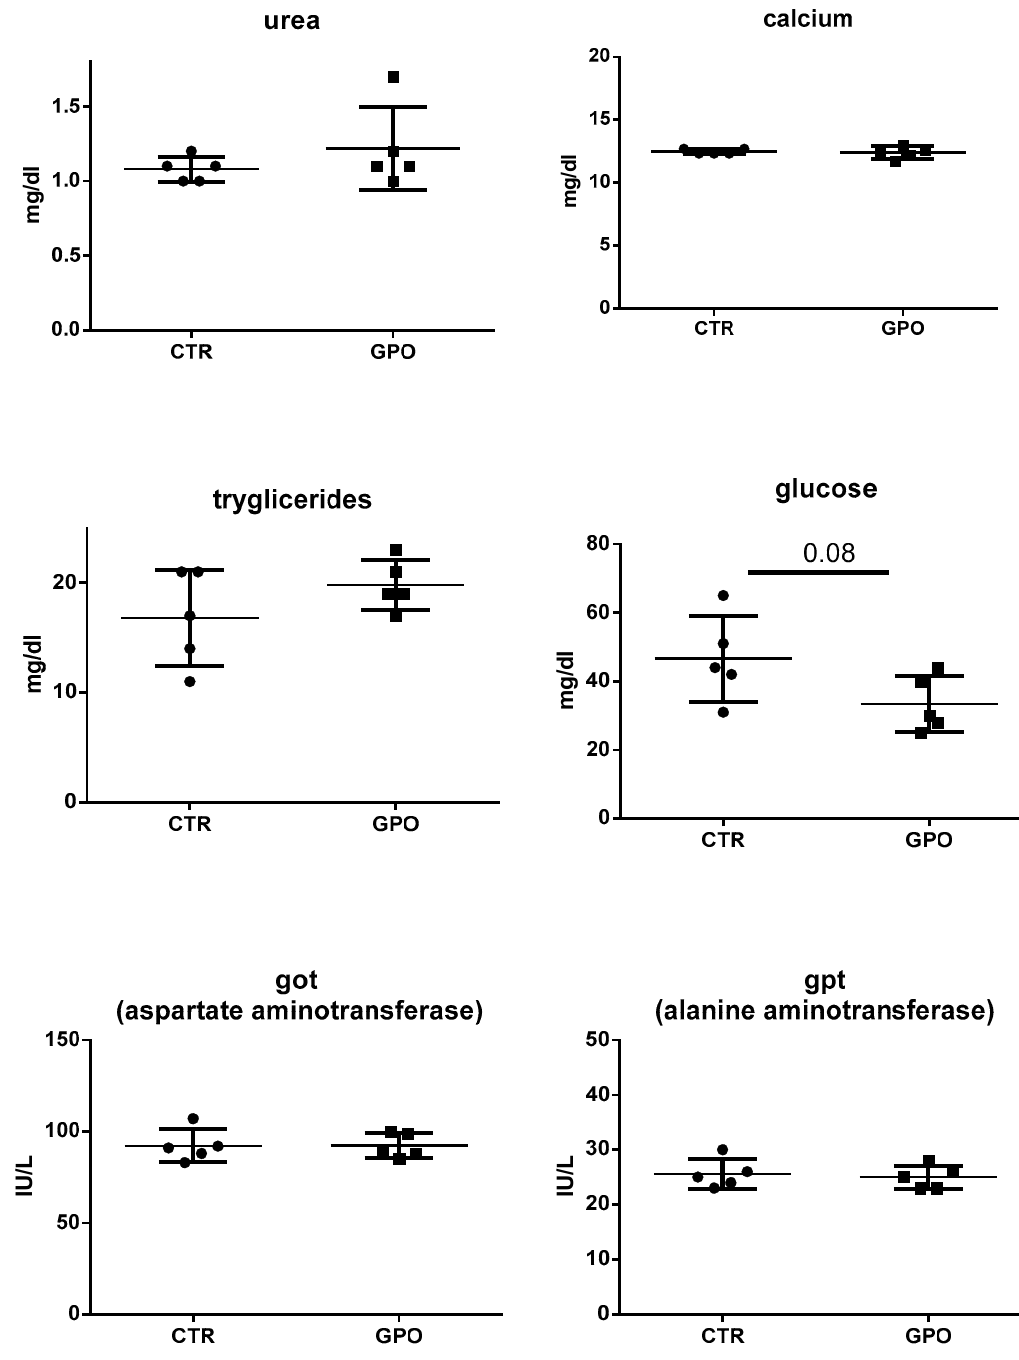
Figure 2. Effect of GPO-supplemented diet on selected plasma parameters. Each point represents a single subject, and possible differences were analyzed by using the Student’s t -test.